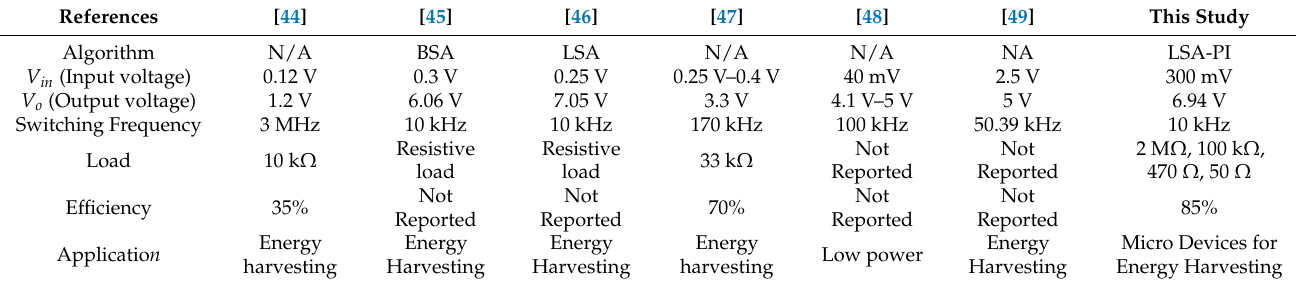
Table 8. Comparison of results between the present and conventional